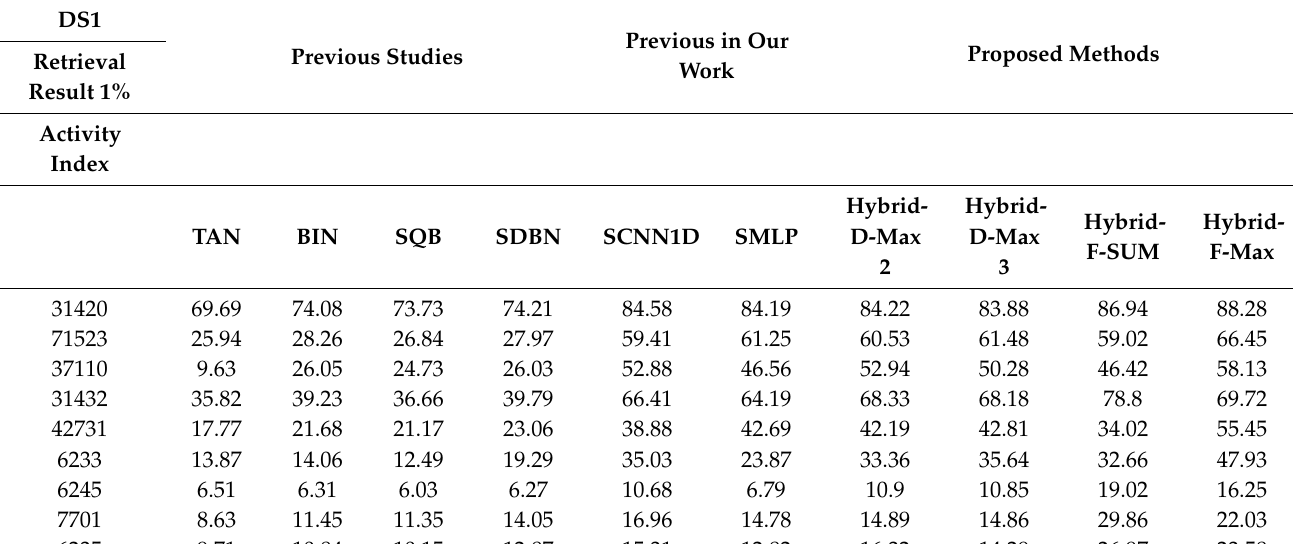
Table 5. Top 1% retrieval recall for MDDR-DS1 (structurally homogeneous and heterogeneous) dataset for descriptor (ECFC 4).